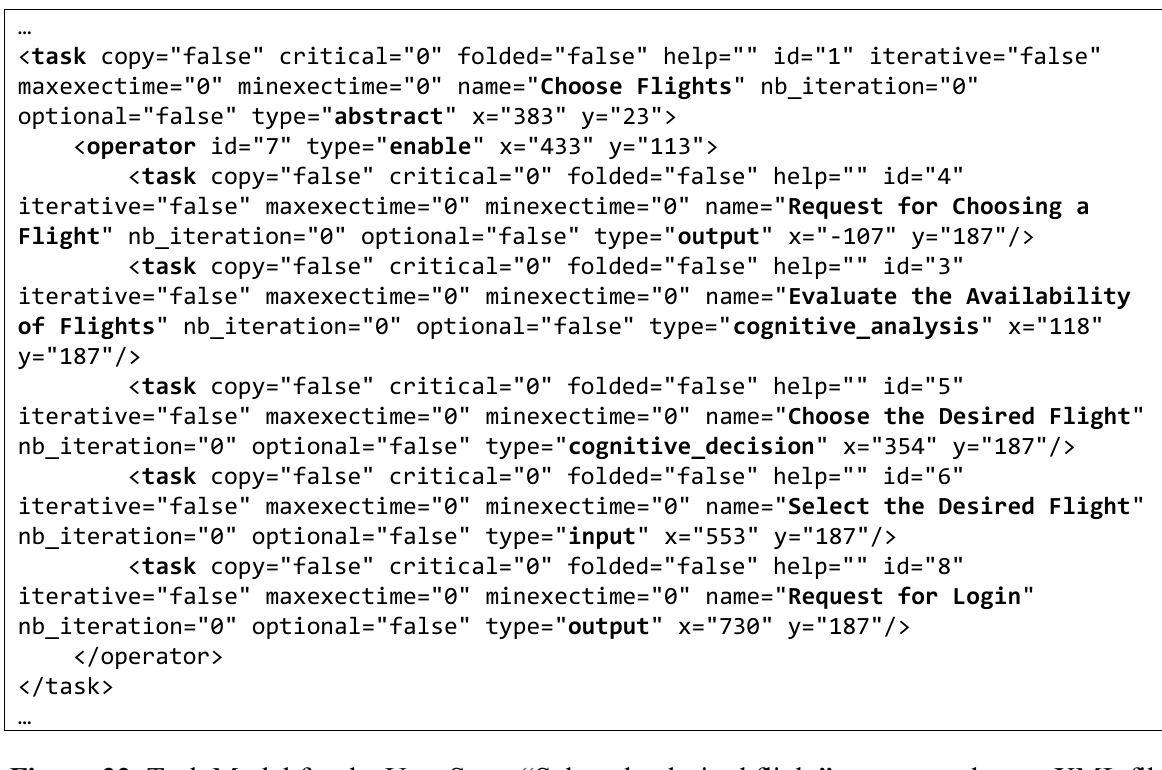
Figure 22. Task Model for the User Story “Select the desired flight” represented as an XML file with the components for testing